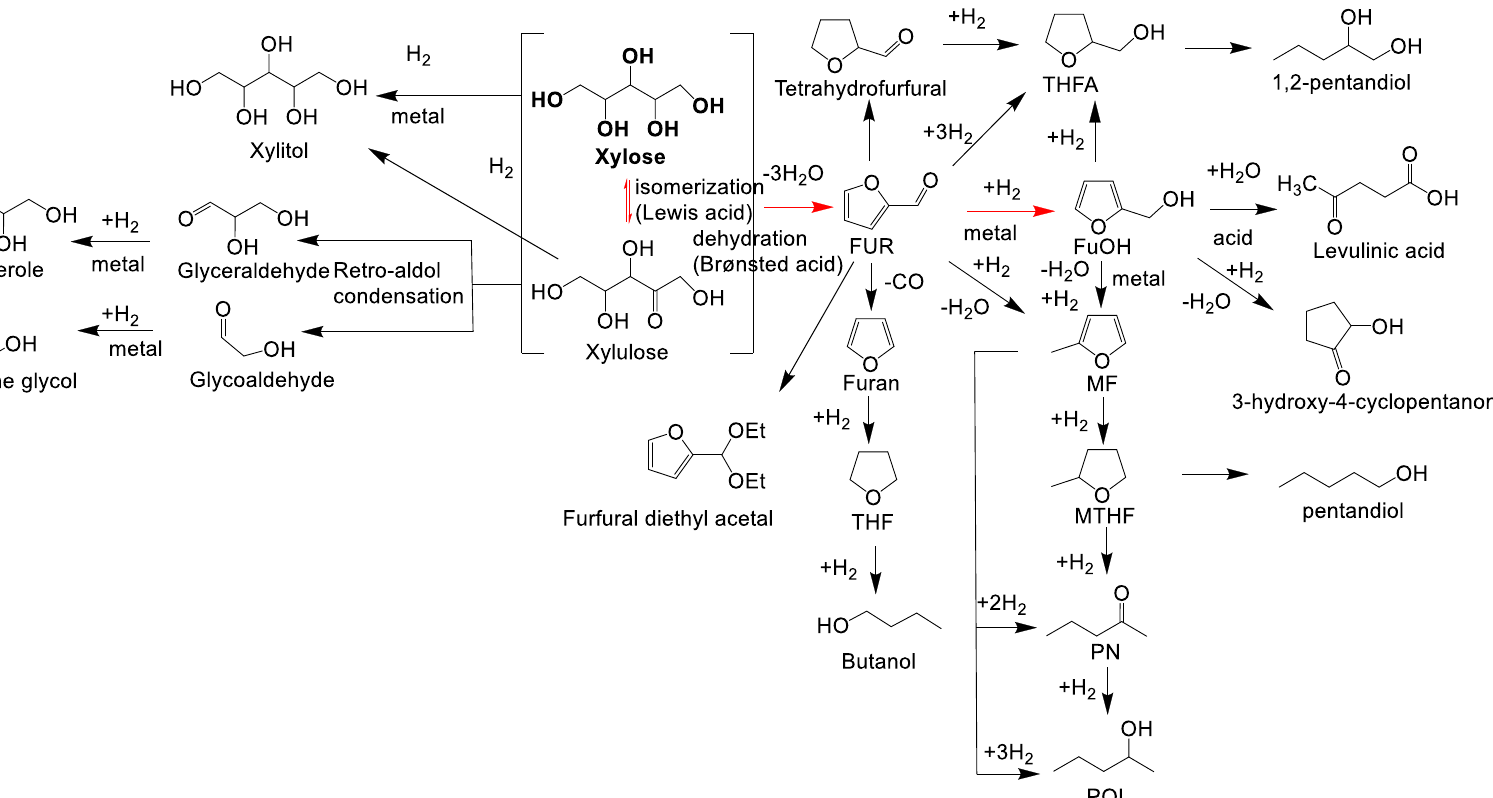
Figure 1. Possible reaction routes of the one-pot transformation of xylose to furfuryl alcohol. Adapted from [37,51–53].